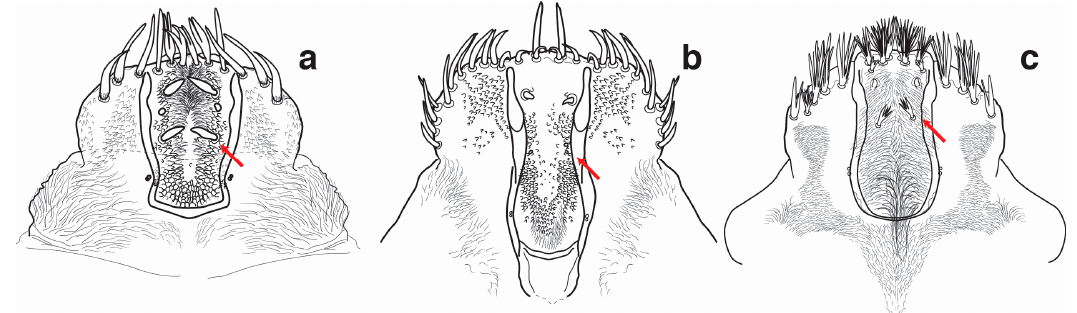
Figure 34. Epipharynx, larva: ( a ) Nassophasis ; ( b ) Rhynchophorus palmarum ; ( c ) Yuccaborus .